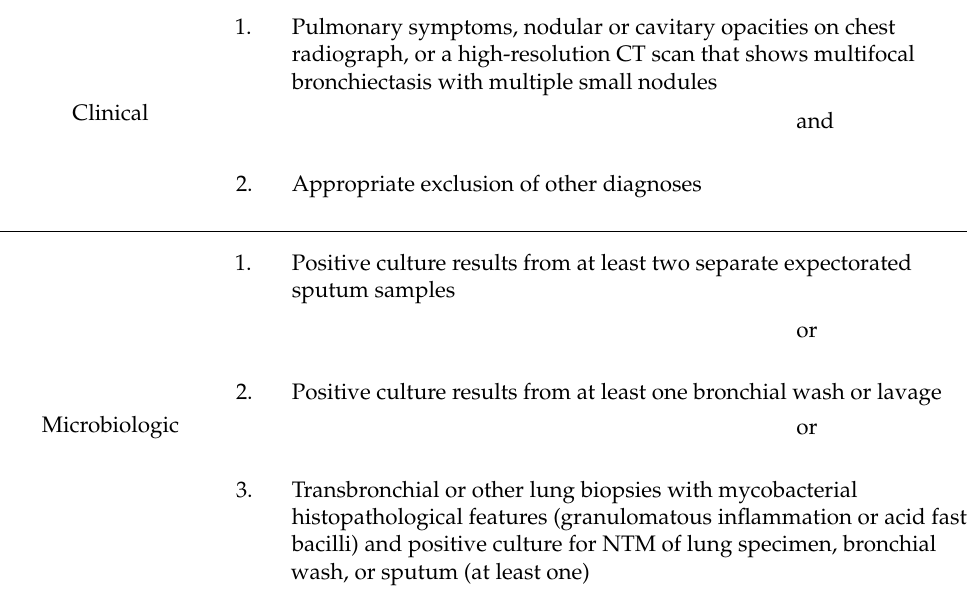
Table 2. NTMLD diagnostic criteria based on ATS/IDSA recommendations